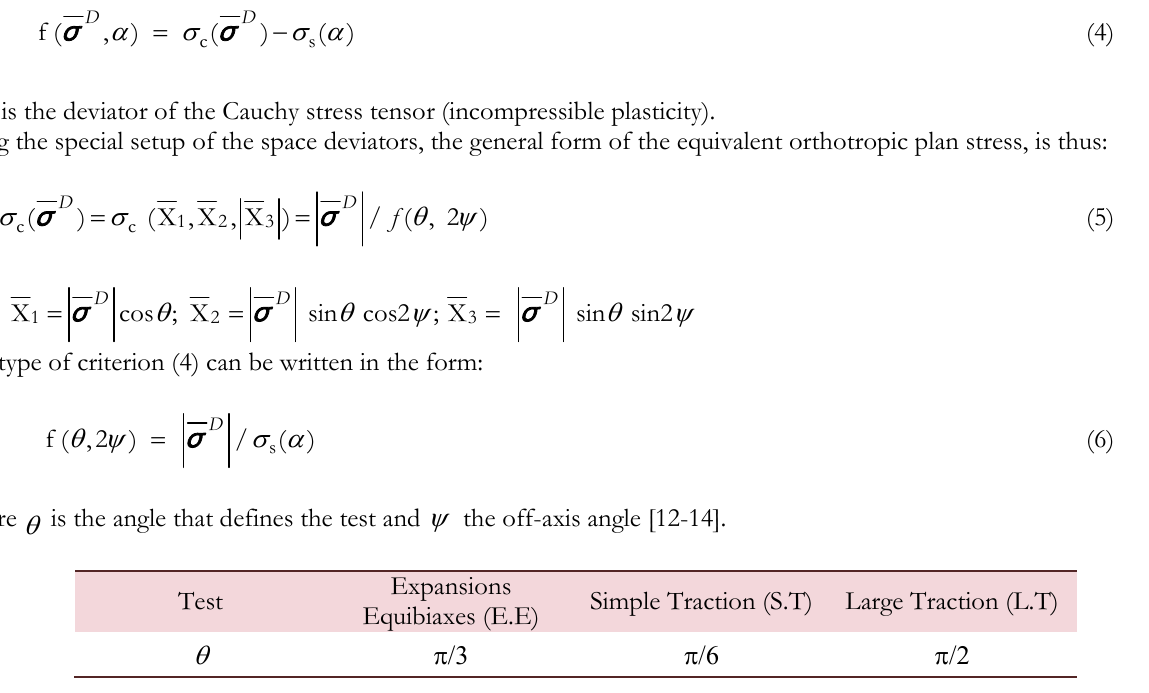
Table 1: Values of θ relative to the various